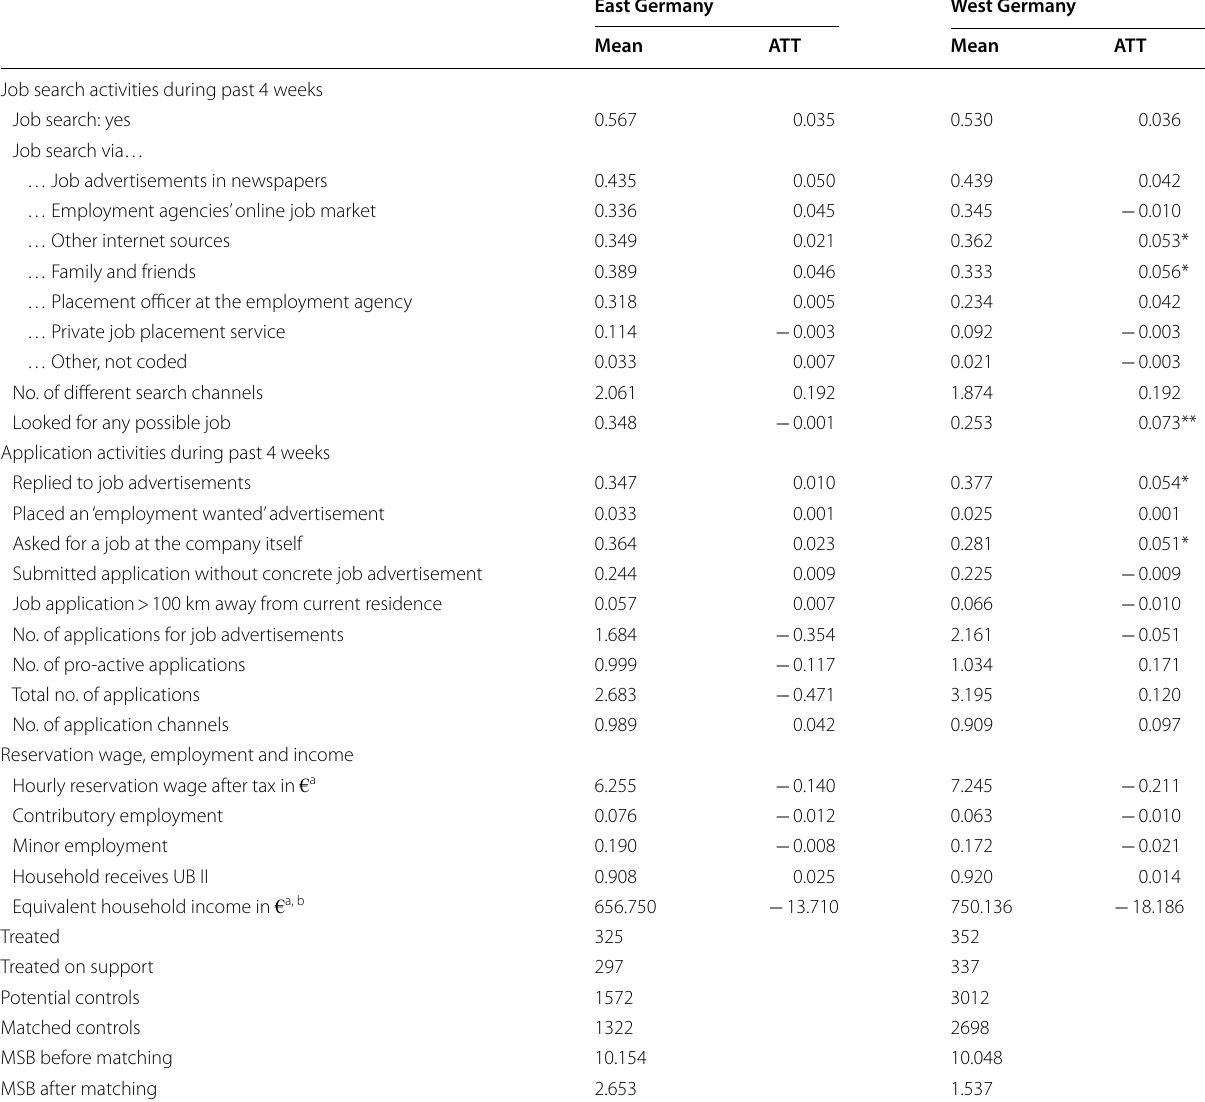
Table 5 ATT of receiving a One‑Euro‑Job announcement and mean outcomes for matched controls by region.